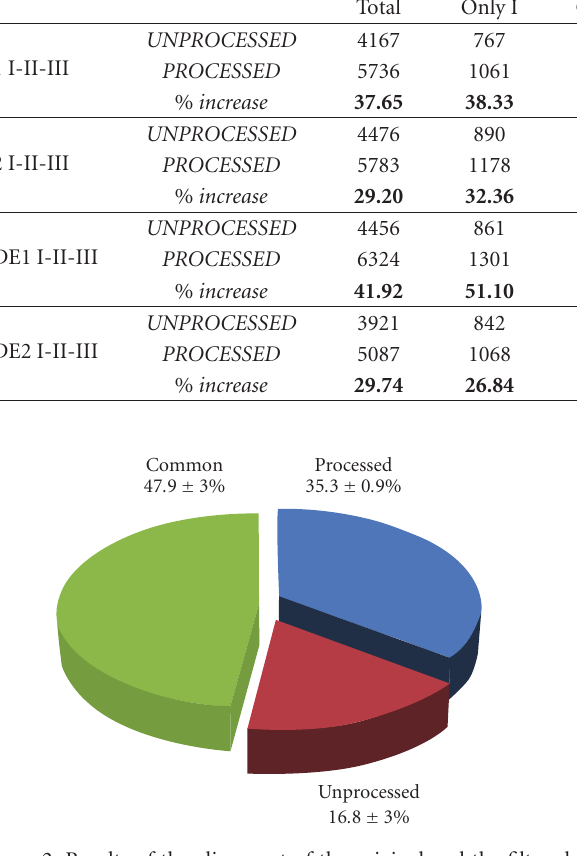
Figure 2: Results of the alignment of the original and the filtered files of all 12 LC-MS run. Common: features found in both maps; processed: features found only after noise rejection; unprocessed: features found only in the original maps.